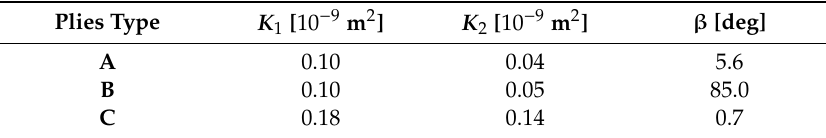
Table 7. Principal permeability of the carbon textile.